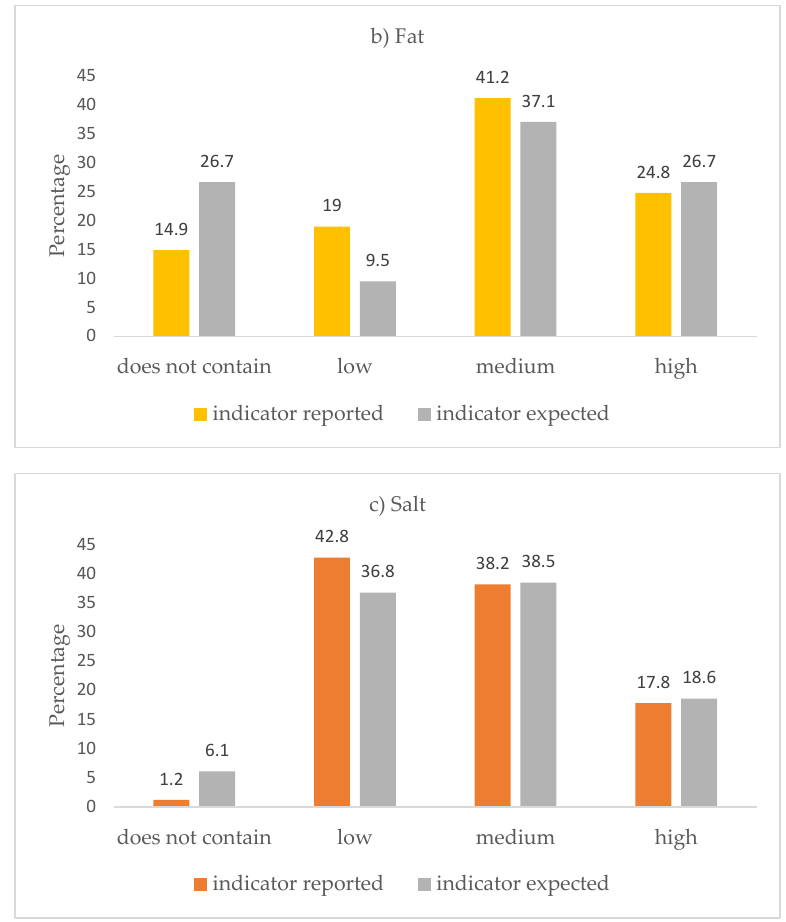
Figure 1. Proportion of TL indicators reported and expected by type of nutrient (n = 1725). The indicator “does not contain” was considered when the values of sugar, fat, or sodium were zero; ( a ) chart for sugar, ( b ) chart for fat, ( c ) chart for salt (sodium). Table 5. Consistency between the information reported on the TL label and the estimation based on the nutrition table and the concentration indicators reported on the TL label, 93.6% ( K = 0.88) of products nutrition table (n = 1455).